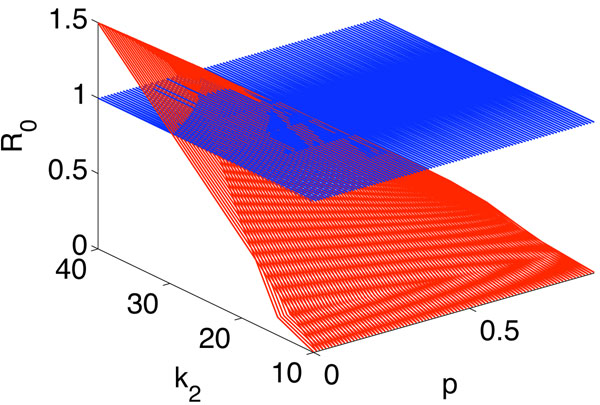
R0 as a function of k2 and p. R0 is plotted as a function of k2 and p. Here, k1 = 10, λ1 = λ2 = 0.0104, δ = 0.4, α1 = α2 = 1/7 and P(k) = 2m2k–v (m = 3 and ν = 3.5).